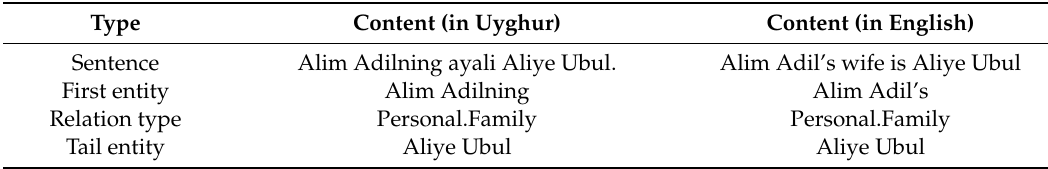
Table 1. A standard Uyghur sentence tagging